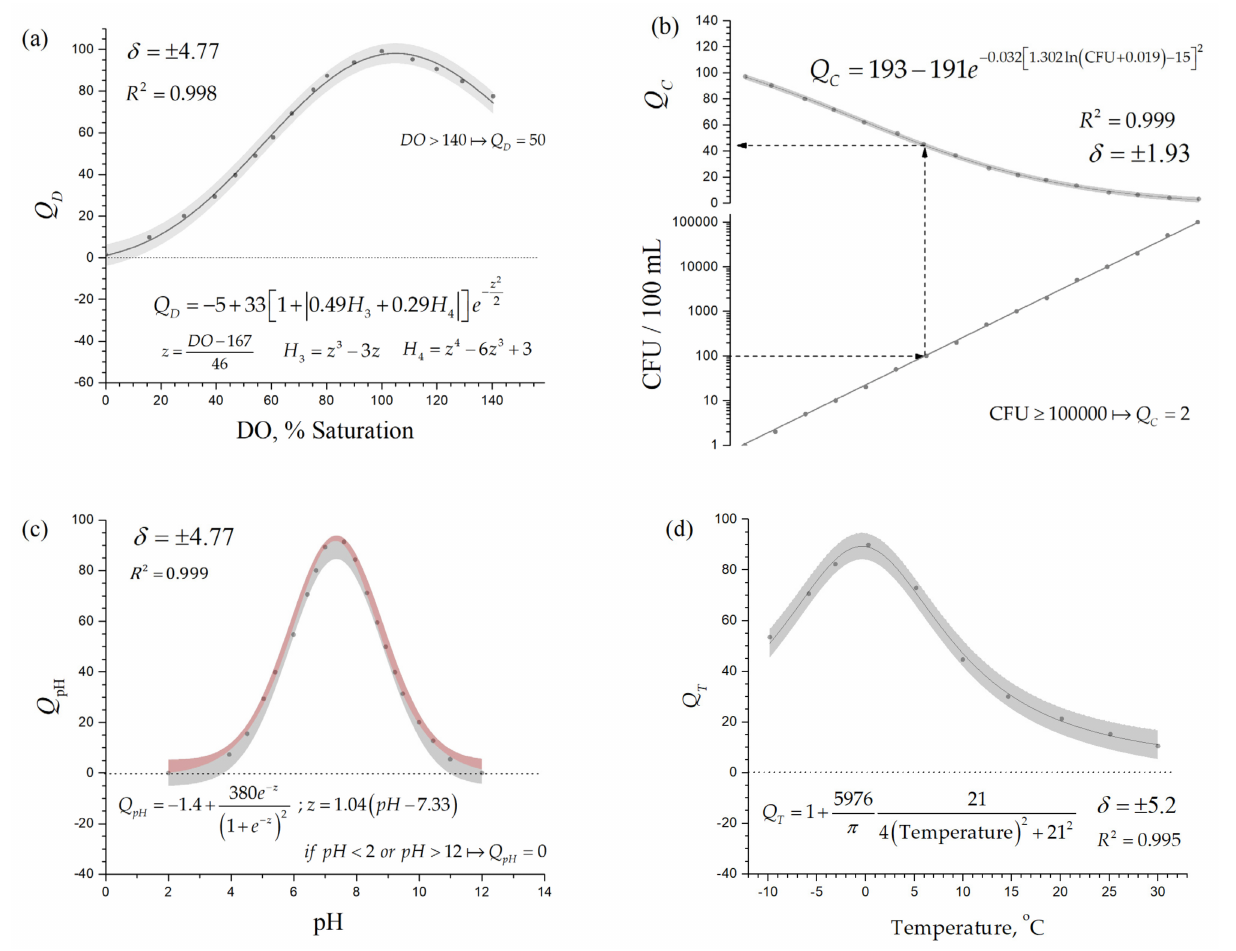
Figure 4. Analytical expressions and uncertainty in value prediction with a margin of 95% confidence for predictor variables utilized in WQI NSF estimations. Dissolved Oxygen ( a ), Fecal Coliforms ( b ), pH ( c ), and Temperature ( d